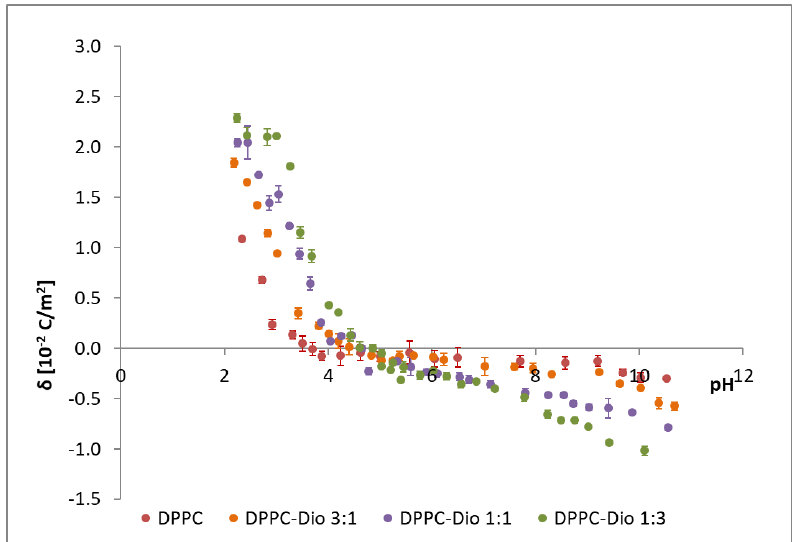
Figure 8. Dependence of DPPC and DPPC: the Dio membrane surface charge densities vs. the pH of the electrolyte solution.